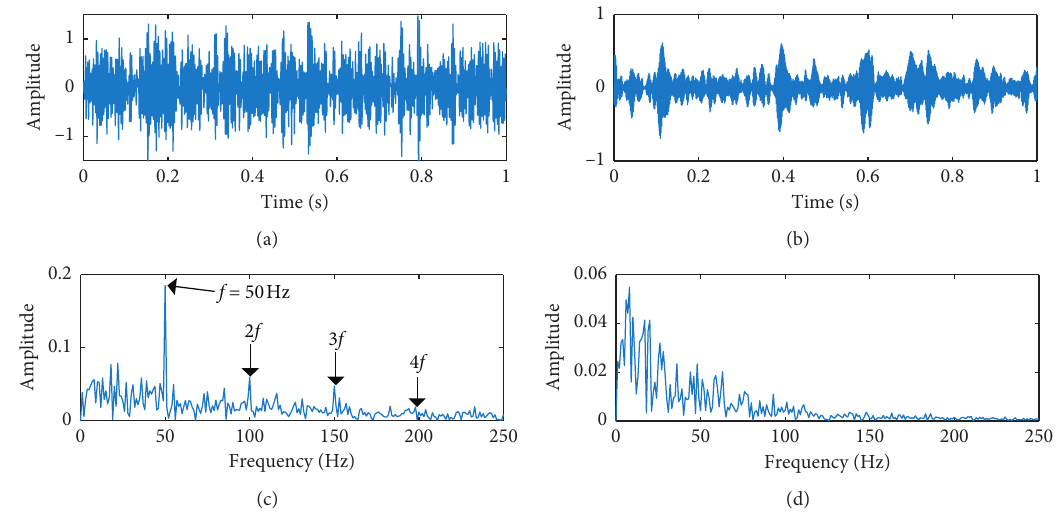
Figure 10: Results of the simulated signal in Figure 6(b) by different ICF locating methods: (a) optimal mode extracted by the proposed method and (c) its envelope spectrum; (b) optimal mode extracted by EFS and (d) its envelope